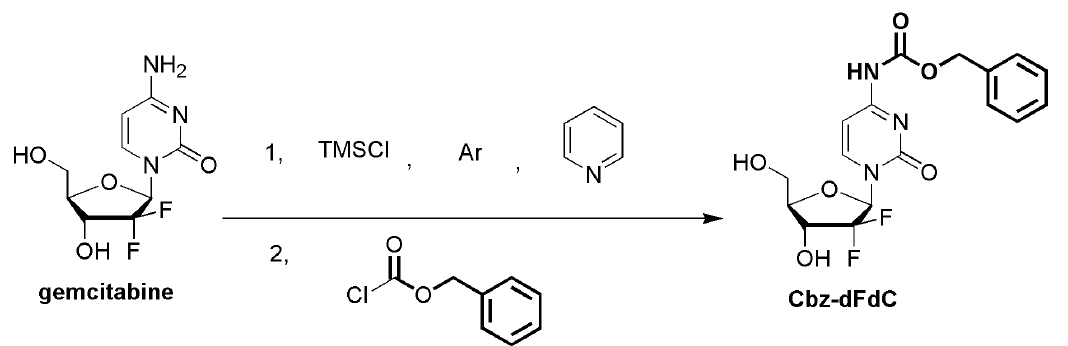
Figure 8. The synthetic route of